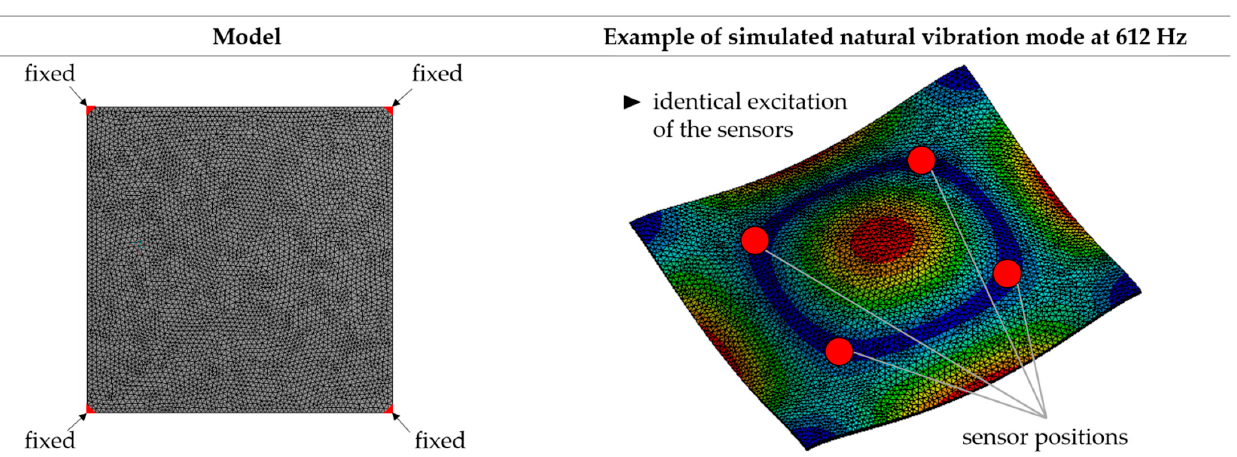
Figure 7. In-plane vibration mode at 11.23 kHz.